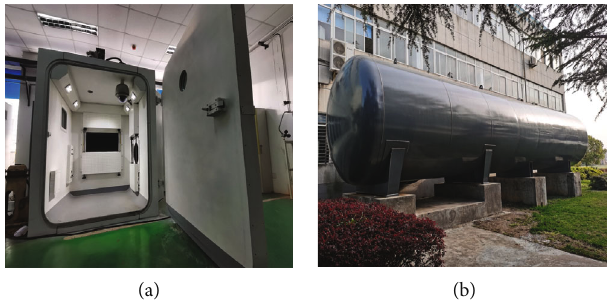
Figure 9: Altitude and vacuum chambers. Table 1: Orthogonal experimental